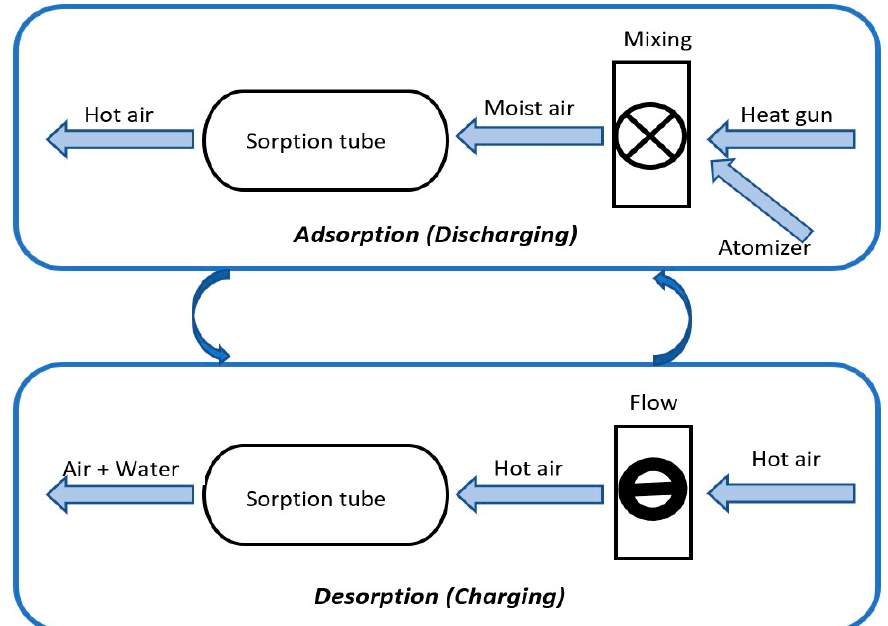
Figure 1. Functional architecture of the proposed storage system.